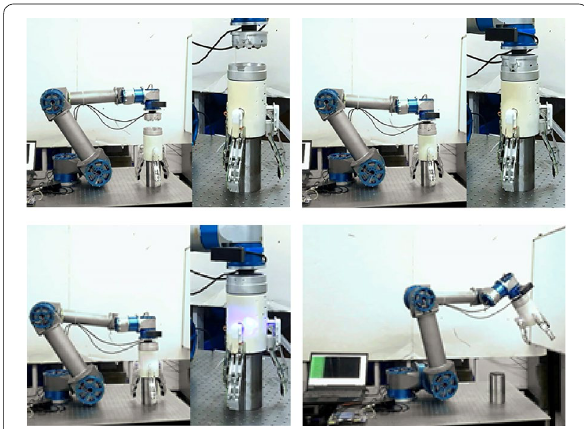
Figure 20 Connection process using the RCM based on SMA